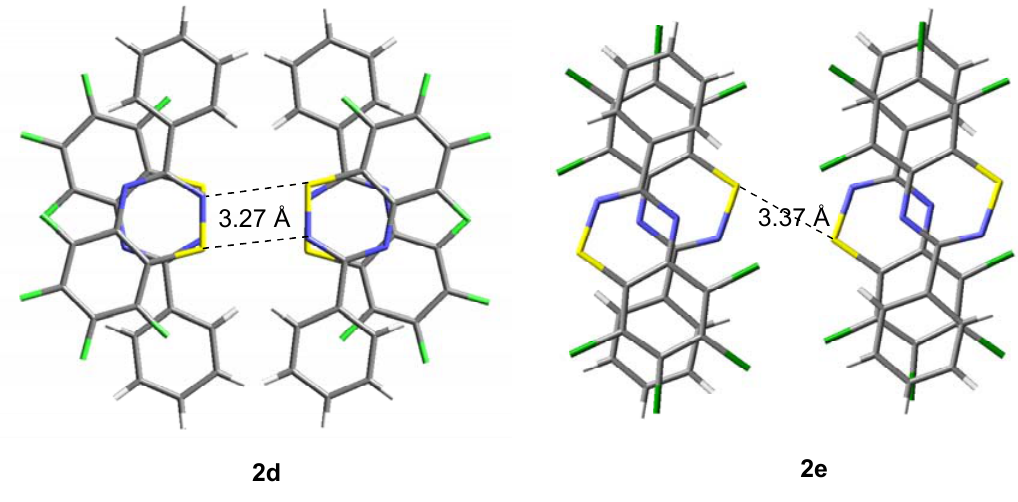
Figure 4 . Partial packing diagrams for 2d and 2e viewed along the c axis ( 2d ) and along the a axis ( 2e